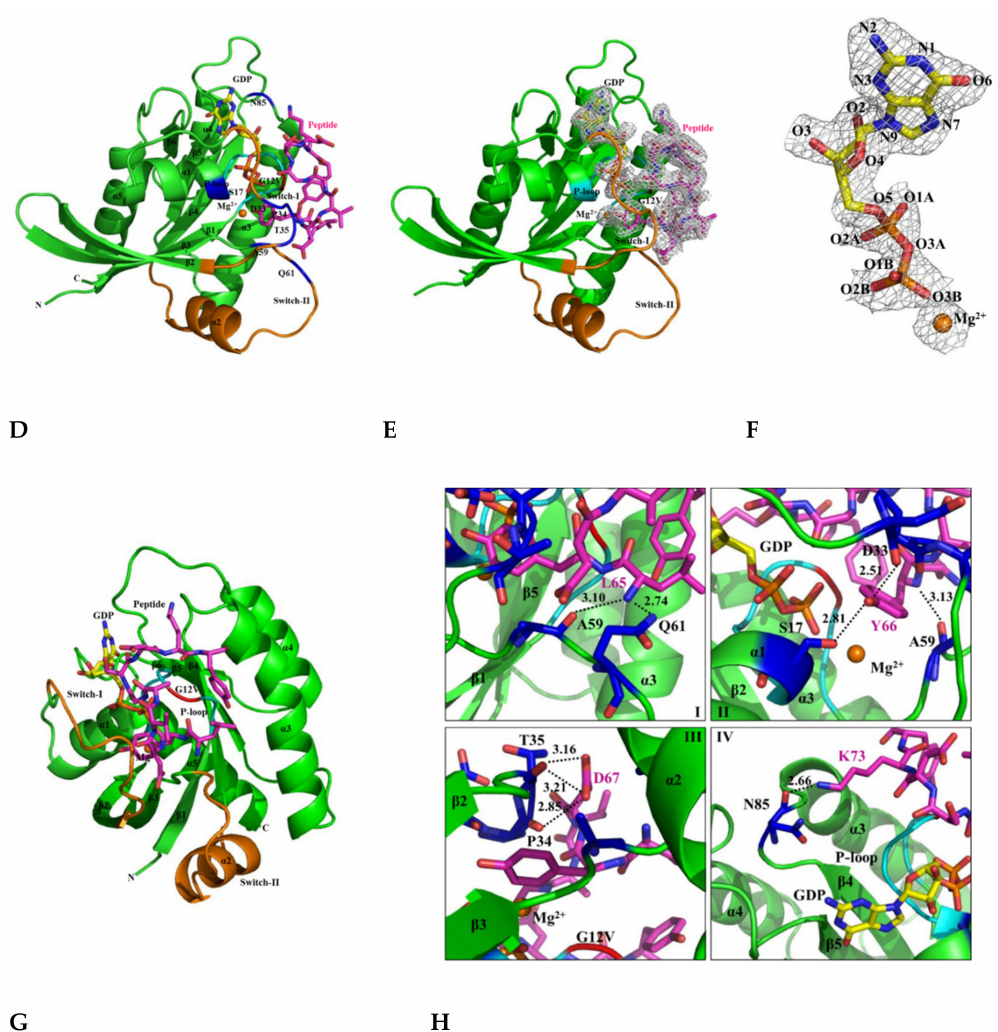
Figure 5. Crystal structures of the KRAS G12V, H-REV107, and KRAS G12V-H-REV107 peptide complex. ( A ) Ribbon representation of monomeric crystal structure of KRAS G12V with MgGDP (orange) is shown. Mg 2 + ion is indicated by orange circle and the GDP is shown as yellow rod. MgGDP molecule is color-coded with C in gray, O in red, N in blue, P in purple, and Mg 2 + ion in orange. ( B ) The crystal structure of the H-REV107 protein is shown in yellow and the fraction of the H-REV107 peptide is shown in purple. ( C ) The 2 F o -F c electron density map of H-REV107 peptide was calculated at 2.3 Å resolution and contoured at 1 σ (gray) at the peptide site. ( D , E ) Crystal structure of KRAS G12V-H-REV107 peptide complex is shown in green. Switch I and II regions in orange and P-loop in blue and peptide in purple are shown. ( F ) Electron density (2 F o -F c ) for bound MgGDP is contoured at 1 σ (gray). ( G , H ) The binding regions of the KRAS and H-REV107 peptide are zoomed in on, and the hydrogen bonds in KRAS G12V and H-REV107 peptide complex are indicated by the black dashed